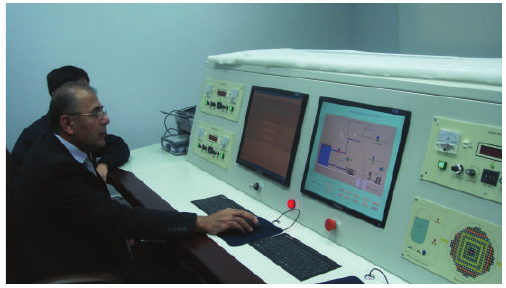
Figure 5: JSA reactor control